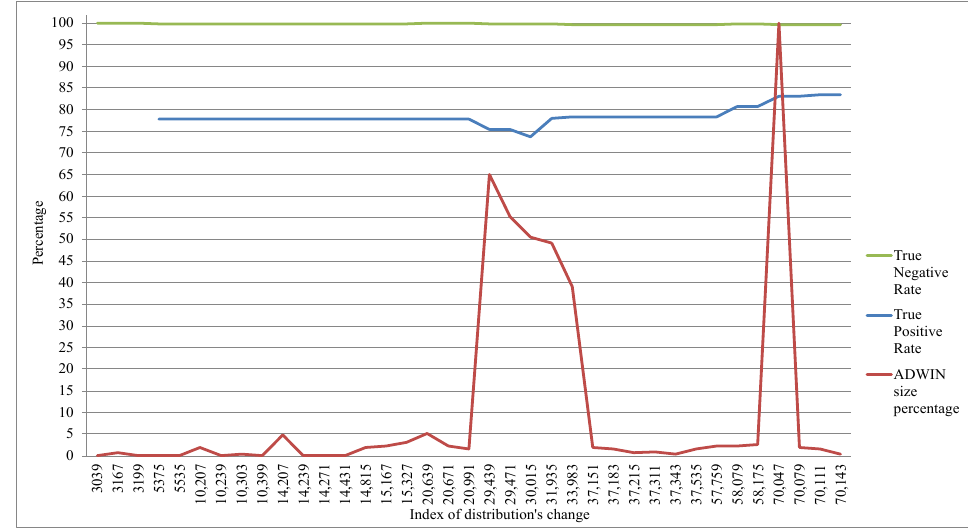
Figure 5. Tracking the performance of ARFC and the change in ADWIN window